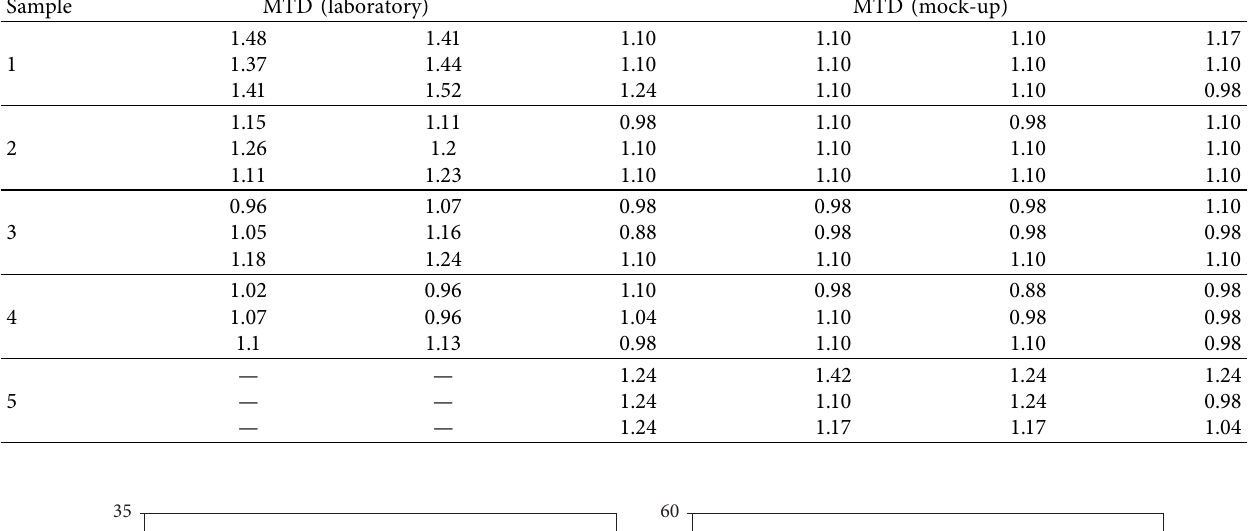
Table 3: Collected mean texture depth from the laboratory and mock-up